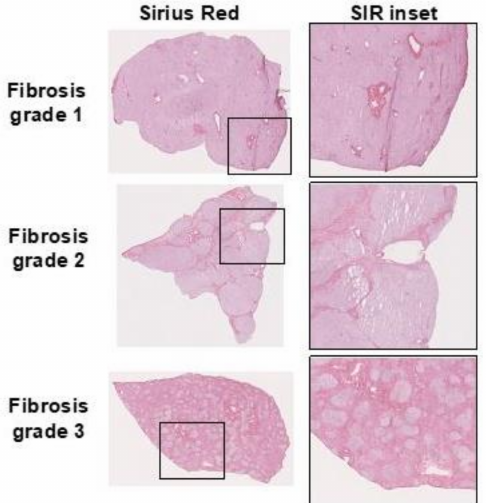
Figure 2. Example of collagen deposits demonstrated by Sirius red (SIR) staining in human liver sections with increasing fibrosis